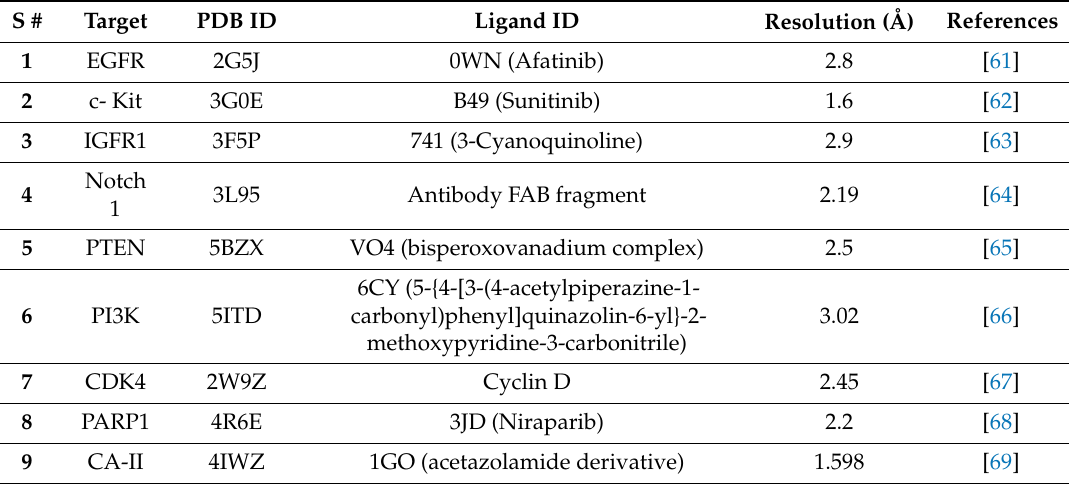
Table 6. The selected PDB structures for each anticancer drug